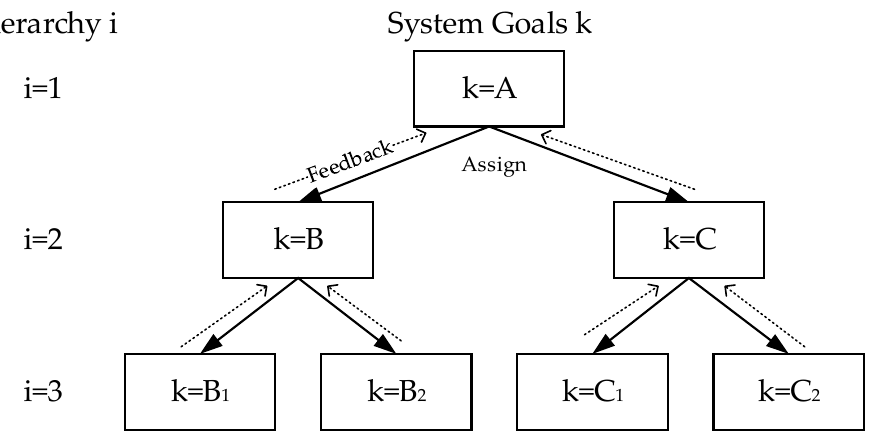
Figure 2. Hierarchical structure diagram of analytical target cascading (ATC).